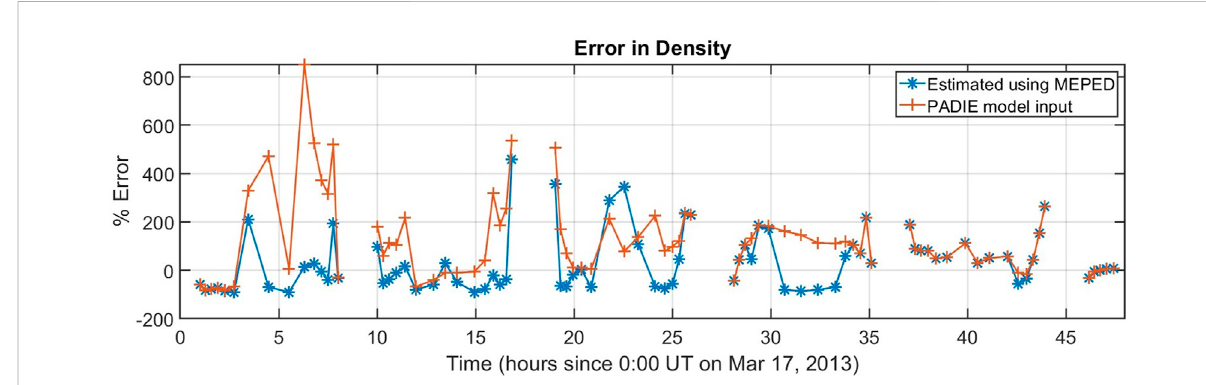
FIGURE 10 Erroranalysisofthedensitymodels.Thepercenterroriscomputedaserror=100*(model-RBSP)/RBSP,whereRBSPisthedensitymeasuredby RBSP-B, and the model densities are from the MEPED scaling estimates (blue), and the PADIE statistical model (orange). By this metric, the MEPED estimated densities are typically closer to the RBSP-B measurements than the PADIE model is.